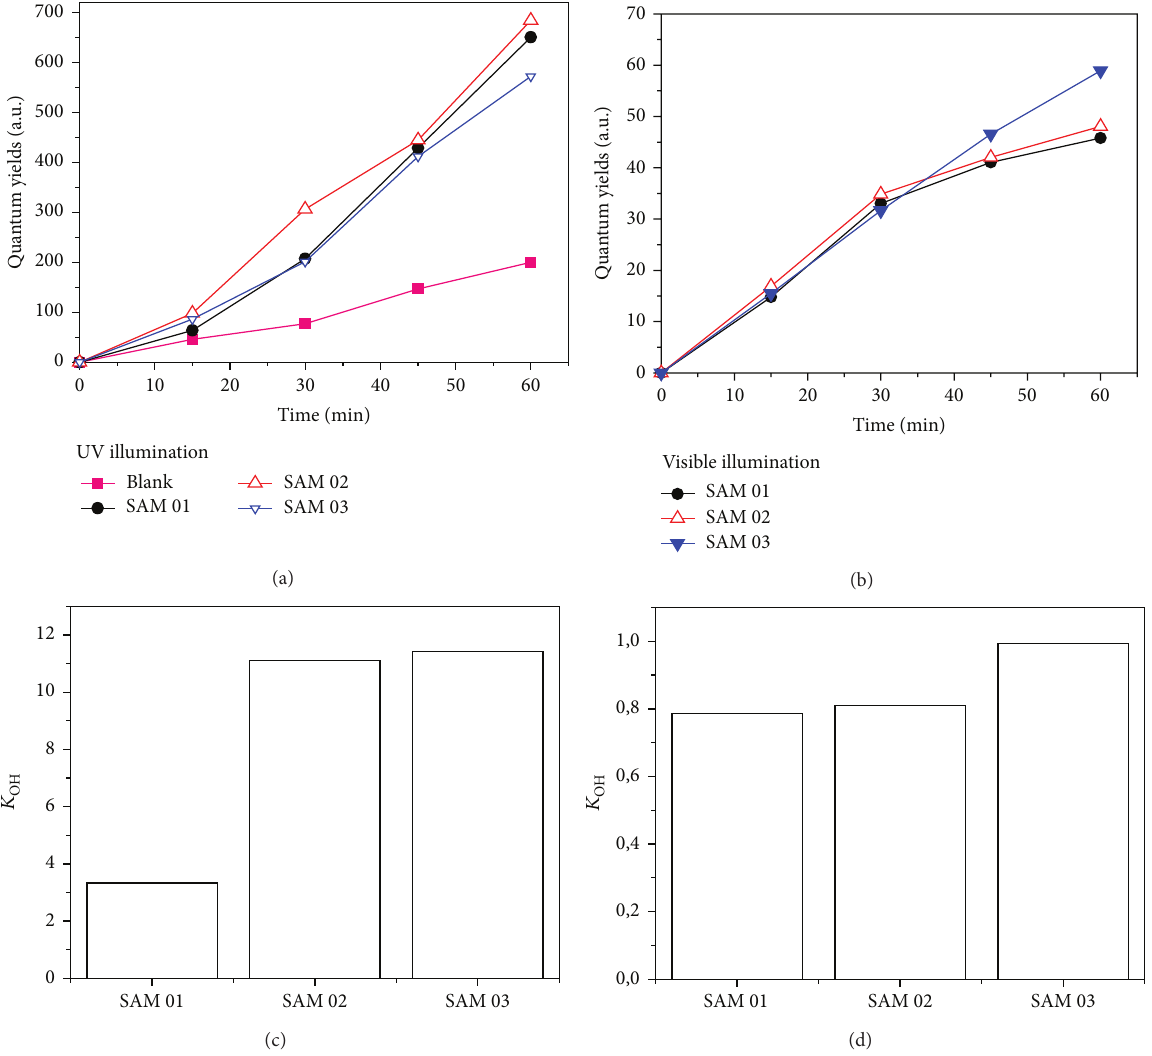
Figure 9: (a) Relation between quantum efficiency of terephthalic acid and hydroxyl radical during UV illumination. (b) Relation between quantum efficiency of terephthalic acid and hydroxyl radical during visible illumination. (c) 𝐾 values for different samples under visible illumination. (d) 𝐾 OH